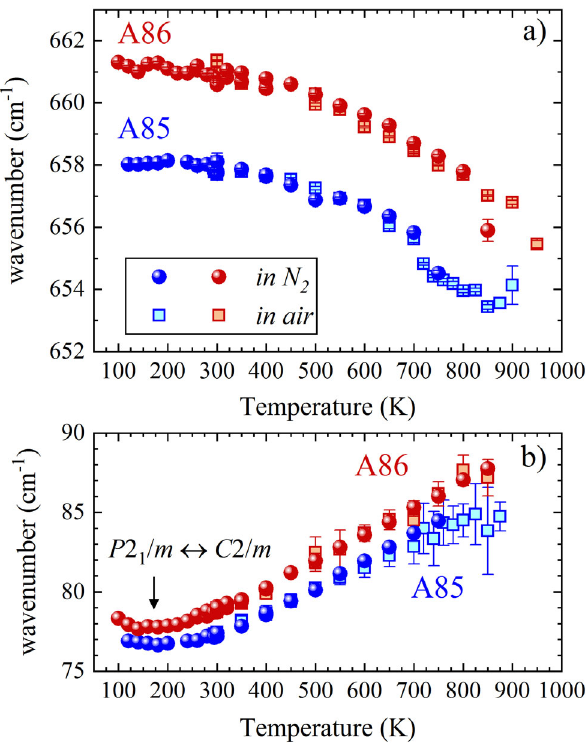
Fig. 8 Temperature dependence of the wavenumber of selected modes for A85 and A86. a Trends for the ring mode; b trends for the chain mode. Data points derived from the (cid:1) y 0 ð zz Þ y 0 spectra measured in situ in N 2 atmosphere are given with circles; data points derived from (cid:1) y 0 ð x 0 x 0 Þ y ’ spectra measured in situ in air are given with squares. Blue symbols refer to A85, red symbols to